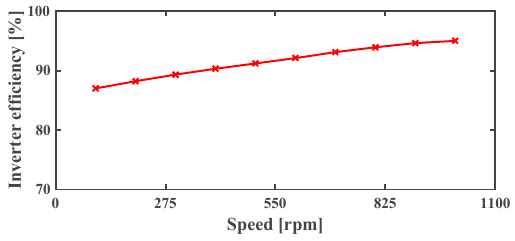
Figure 7. Average switching frequency as a function of the speed.